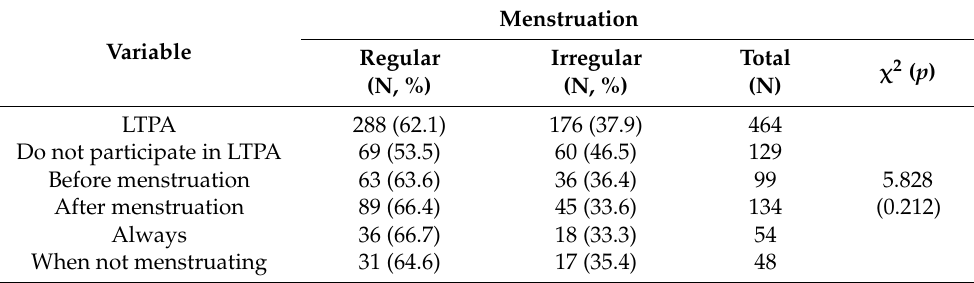
Table 5. t -test among HC, amount of LTPA, and intention to participate in LTPA by regular or irregular menstruation. Regular Irregular Variable M SD M SD HC 3.732 0.6478